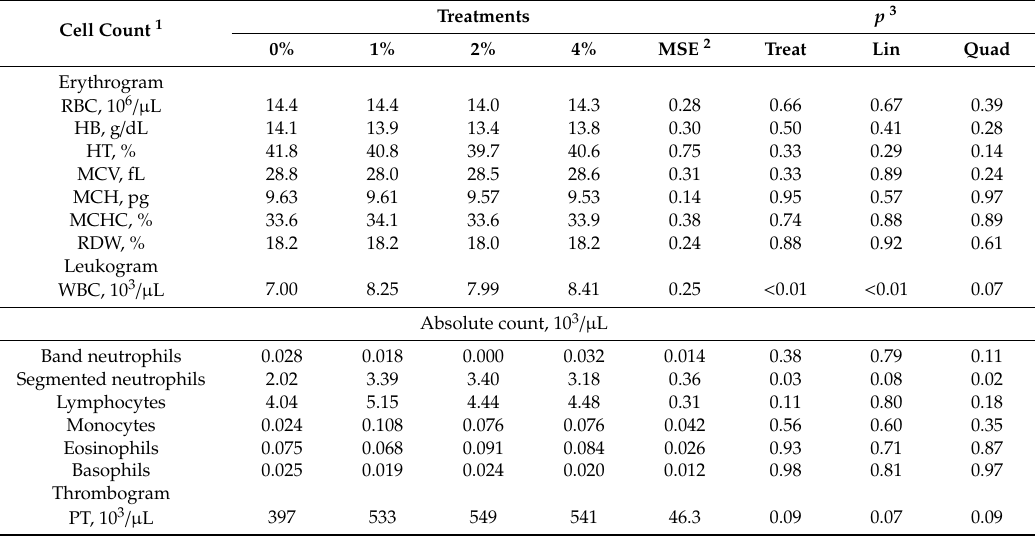
Table 2. Blood cell count of growing lambs fed increased levels of yerba mate extract. Treatments p Cell Count 1